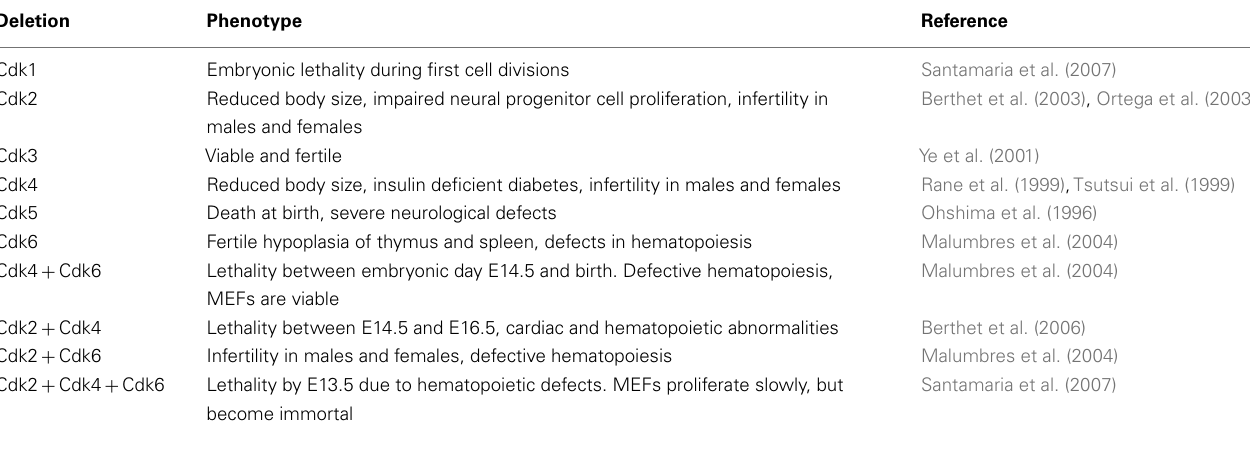
Table 2 | Effect of CDK deletions on mouse